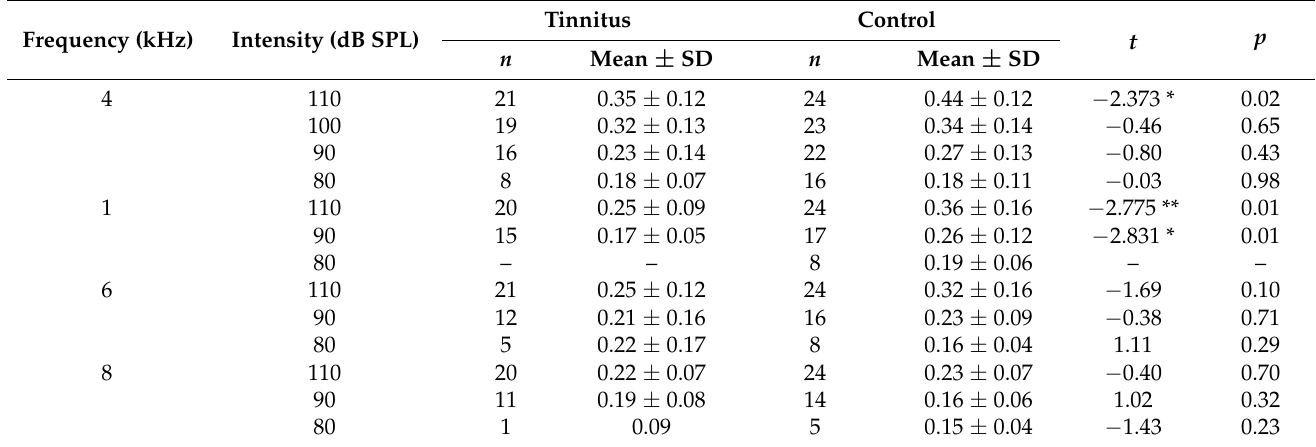
Table 5. Comparison of AP amplitudes between the two groups.